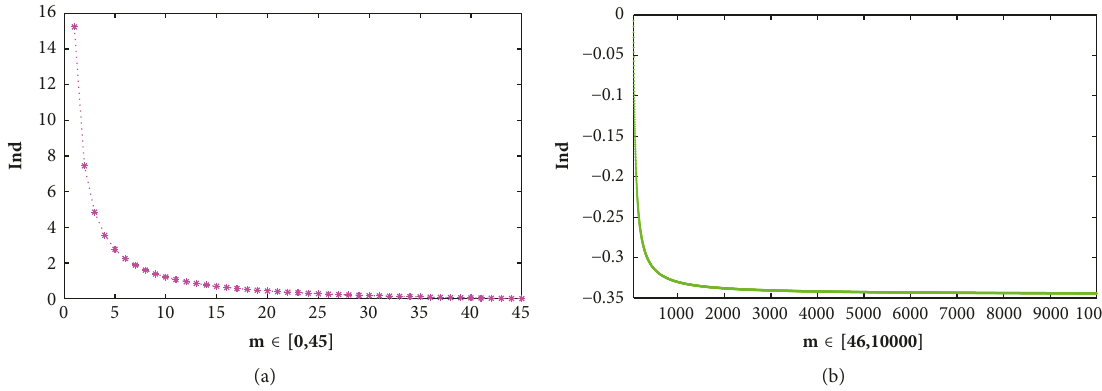
Figure 5: Ind as a function of parameter m ( 𝜃 = 0 , 𝜏 = 1 , Δ𝑥 = 𝜋/10 , 𝑟 1 = 1.0 , 𝑟 2 = 0.5 , 𝑟 3 = −1.0 , and 𝑟 4 = −0.5 ) . (a) 𝑚 ∈ [1,45] . (b) 𝑚 ∈ [46,1000] .